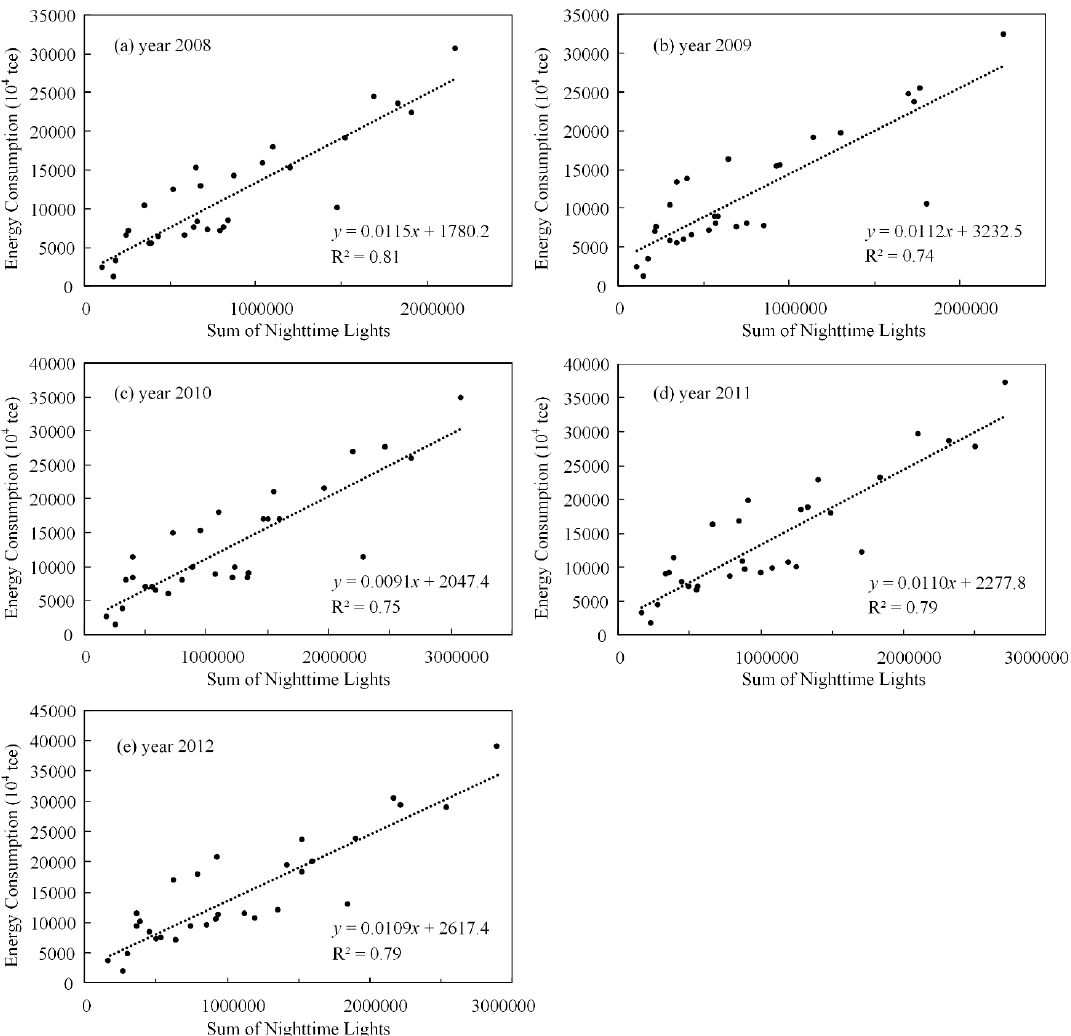
Figure 3. The relationship between energy consumption and the sum of nighttime lights on the provincial scale in each year over the period of 2008–2012. R 2 represents the goodness of the fit.